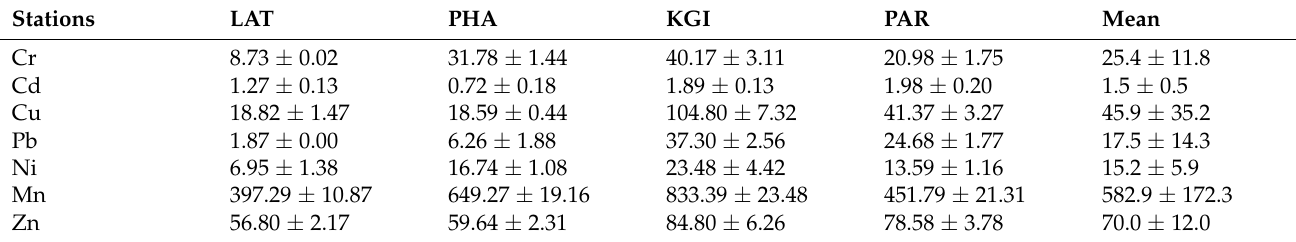
Table A3. Concentrations of Cr, Cd, Cu, Pb, Ni, Mn, and Zn (mg/kg ± S.D. in dry weight “DW”) (n = 3) in the soils of the species Colobanthus quitensis collected at the LAT, PHA, KGI and PAR stations with the mean concentrations of each metal.